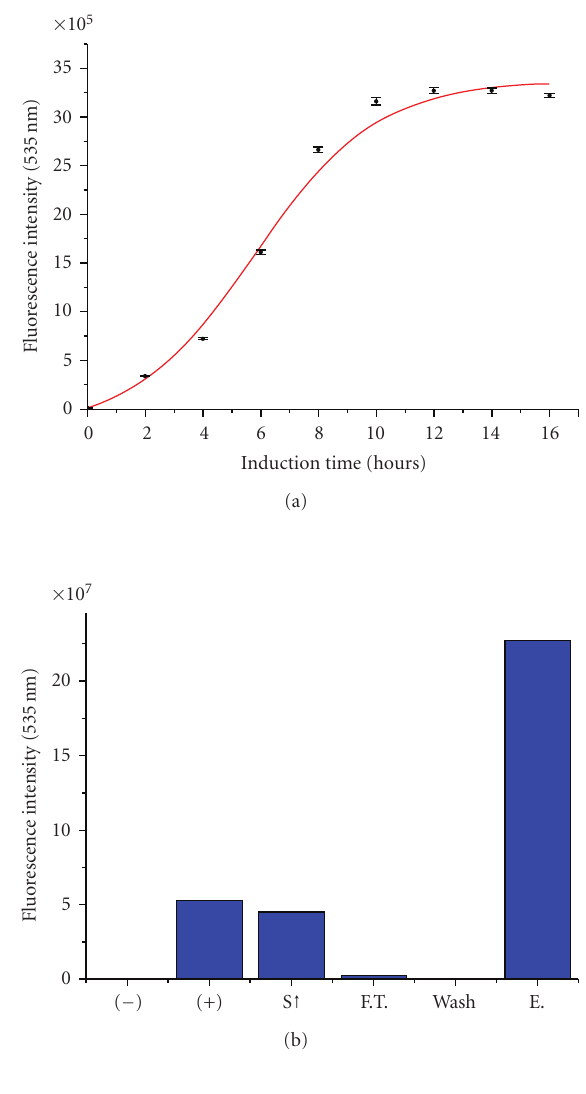
Figure 4: The quantification of sf GFP fluorescence during sf GFP- TEV-His 6 Nd2 expression and purification. (a) The fluorescence intensity versus time curve of sf GFP-TEV-His 6 Nd2 by autoinduc- tion at 19 ◦ C. The fluorescence of 100 μ L cultured E. coli cells in the autoinduction medium was collected using bottom reading method with 485 nm excitation filter and 535 nm emission filter. The height of the bar is the average of three independent tests with standard error on top of the bar. (b) One representative sf GFP fluorescence quantification during Ni-NTA purification. The fluorescence was collected using top reading method with 485 nm excitation filter and 535 nm emission filter. ( − ): uninduced cell lysate; (+): induced whole cell lysate; S ↑ : supernatant of the sonication; F.T.: flow through fraction from Ni-NTA chromatography; Wash: wash fraction from Ni-NTA chromatography; E.: eluated fraction by imidazole from Ni-NTA